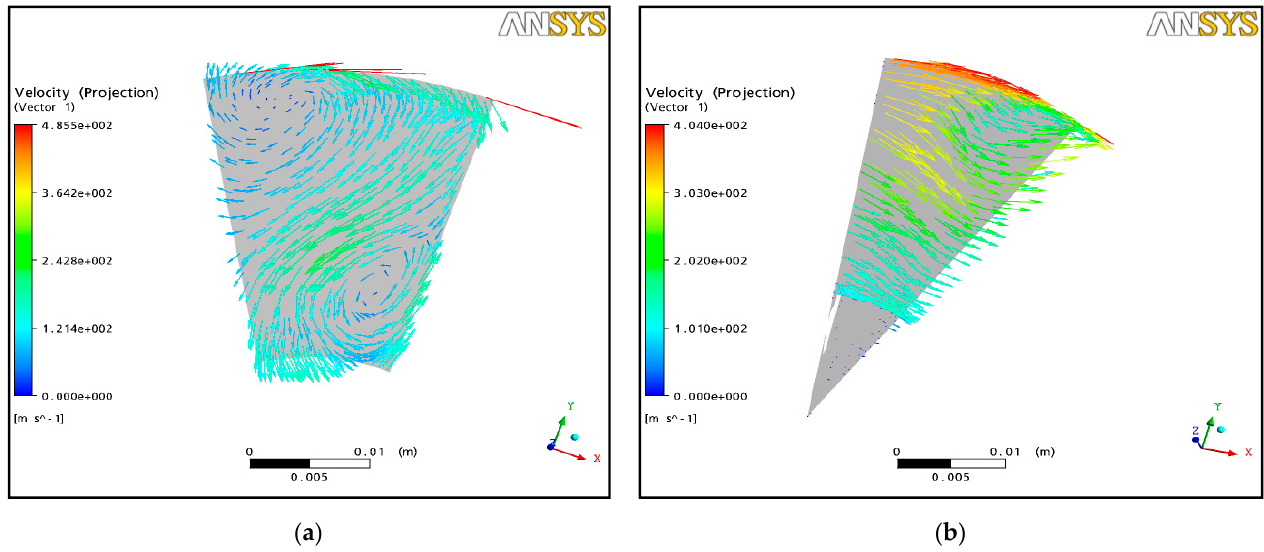
Figure 12. Tangential relative velocity field: ( a ) tangential relative velocity field in rotor inlet; ( b ) tangential relative velocity field in rotor outlet.